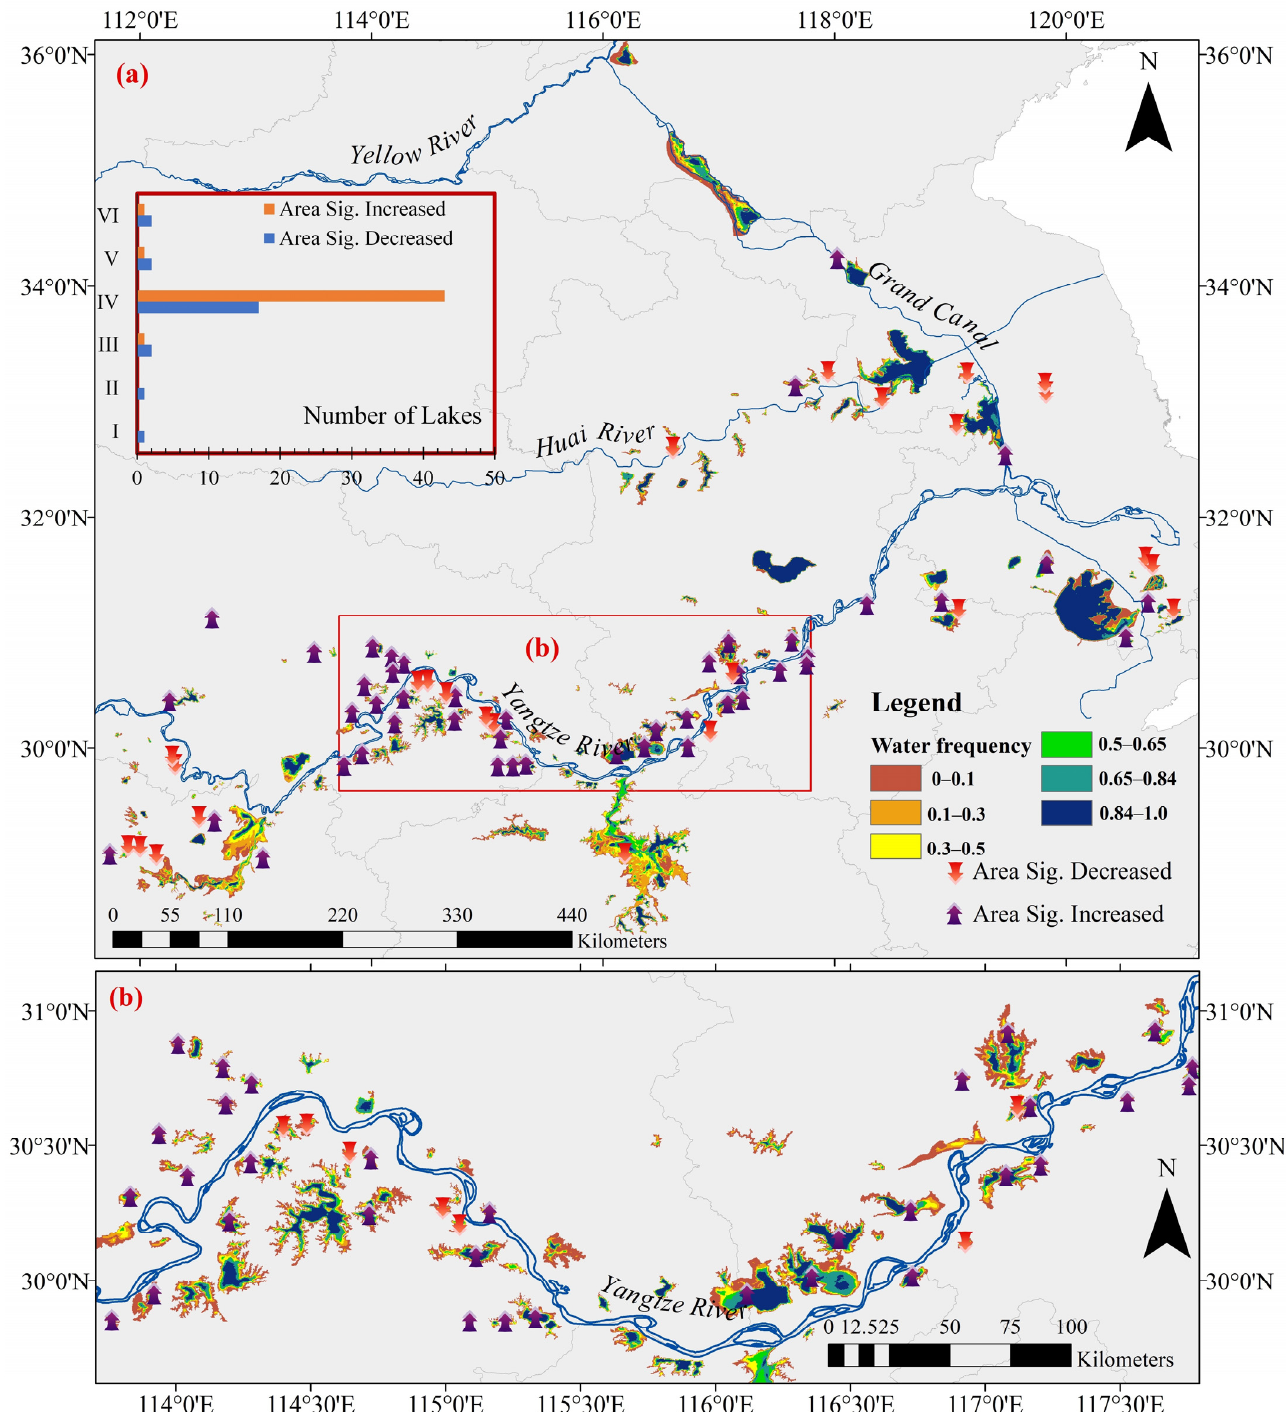
Figure 1. Locations of the 184 study lakes in the EPL region and MODIS-derived annual water frequency, ( a ) the EPL region and the inset shows the number of lakes with decreasing or increasing trends in annual area for the six classes, ( b ) the middle of the Yangtze Plain. Lakes for which the annual lake area significantly ( p < 0.05) increased or decreased are marked with the symbol “ ↑ ” or “ ↓ ”, respectively.